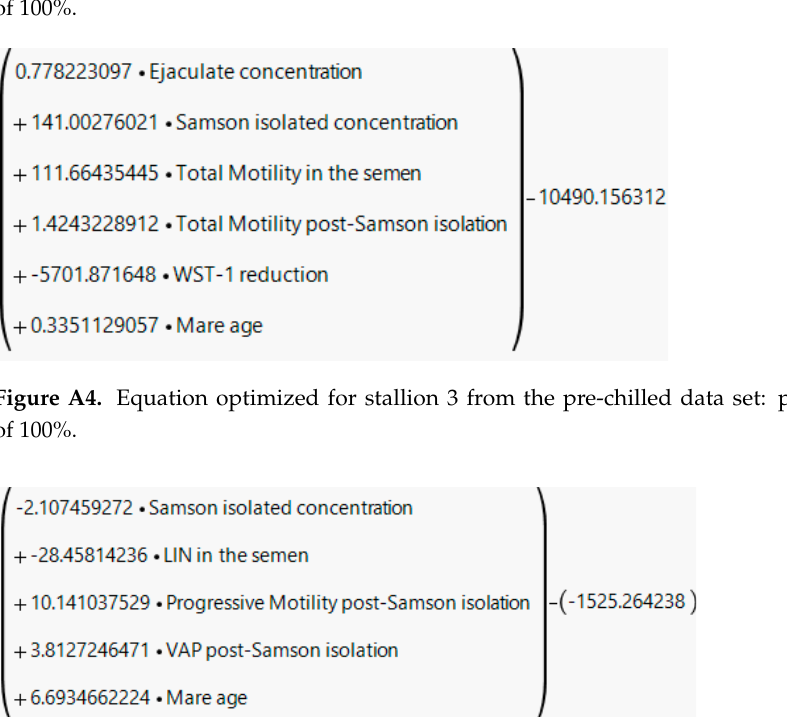
Figure A5. Equation optimized for stallion 4 from the pre-chilled data set: predictive accuracy of 75%.